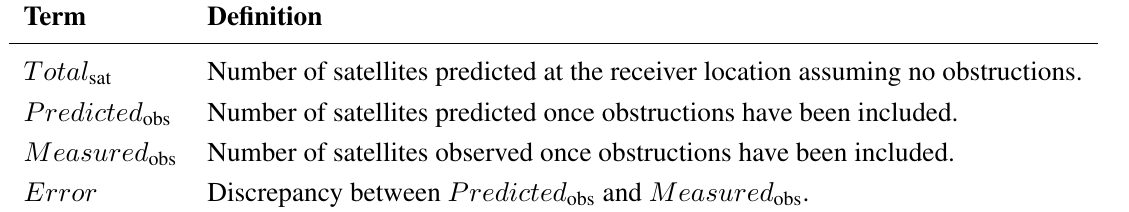
Table 1. Global navigation satellite system (GNSS) prediction validation test